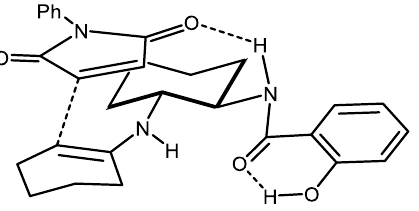
Figure 4. Suggested transition state leading to the formation of 11aa